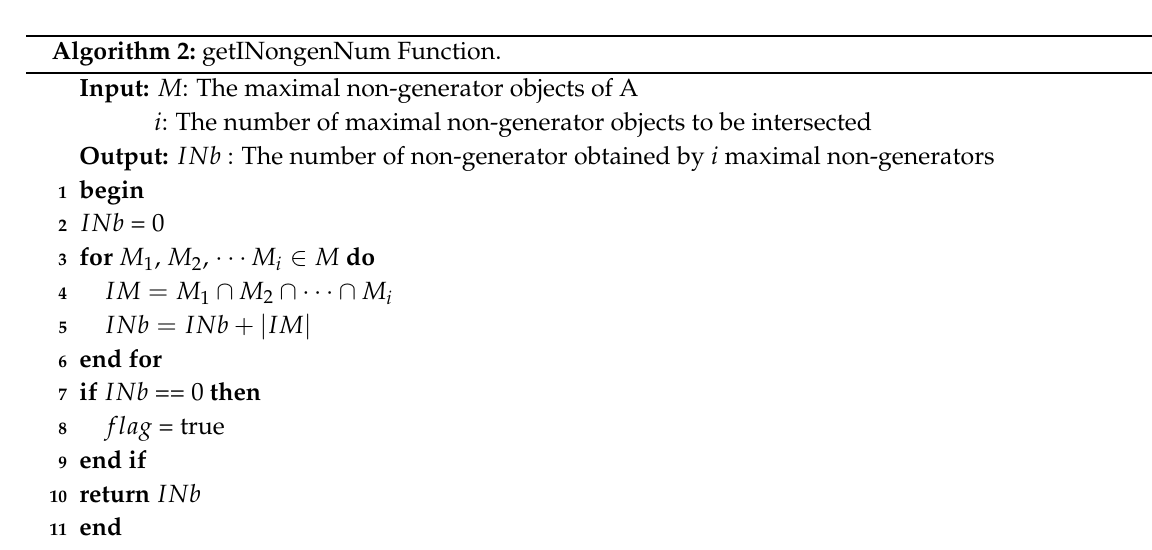
Algorithm 2: getINongenNum